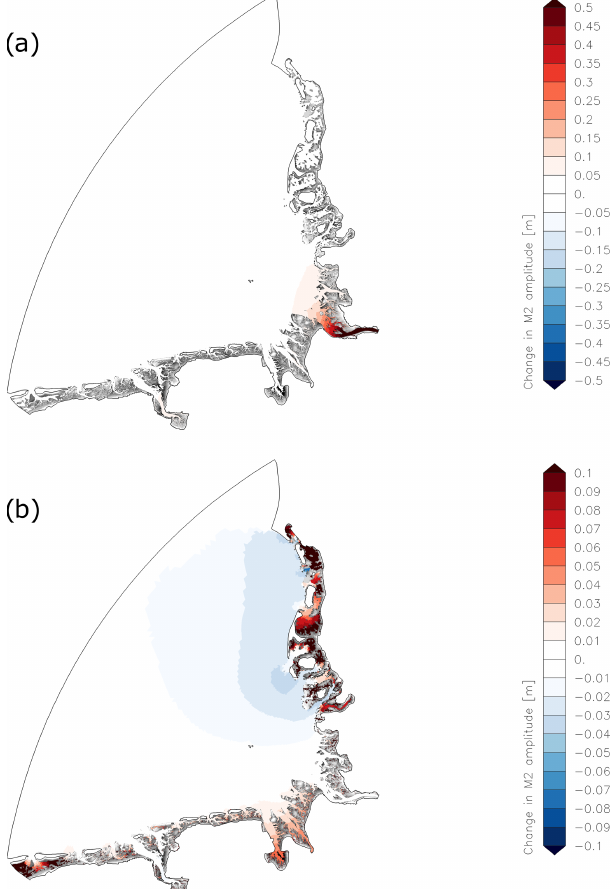
Figure 8. (a) Changes in M2 amplitude due to the coarser bathymetry (increase in red, decrease in blue, dry areas in grey) (GBM_ref_ NE_CB – GBM_ref_NE). (b) Changes in M2 ampli- tude due to MSLR 0.8m in the German Bight Model with coarse bathymetry (increase in red, decrease in blue) (GBM_80_NE_CB – GBM_ref_NE_CB).